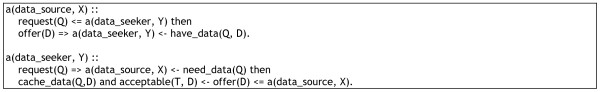
An interaction model for competitive data sharing.